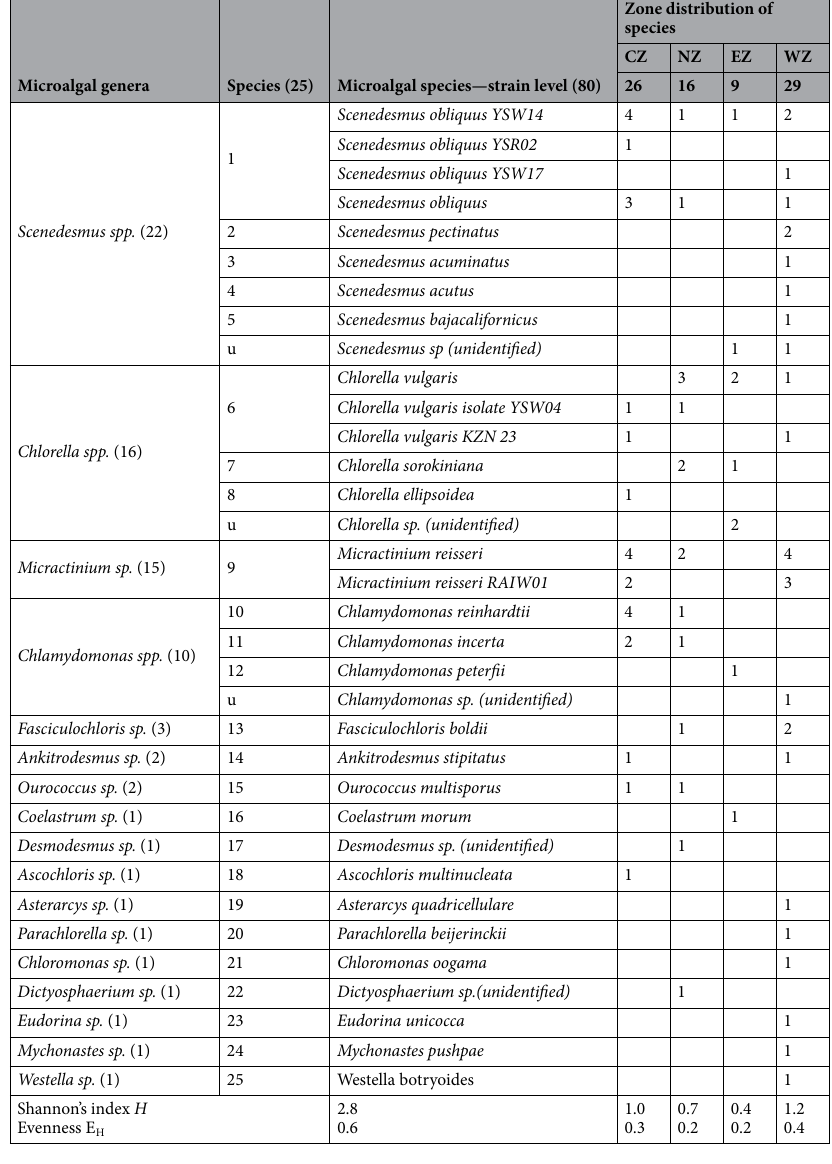
Table 1. Microalgal diversity among LSU-rDNA sequenced microalgae and their distribution. u-Species